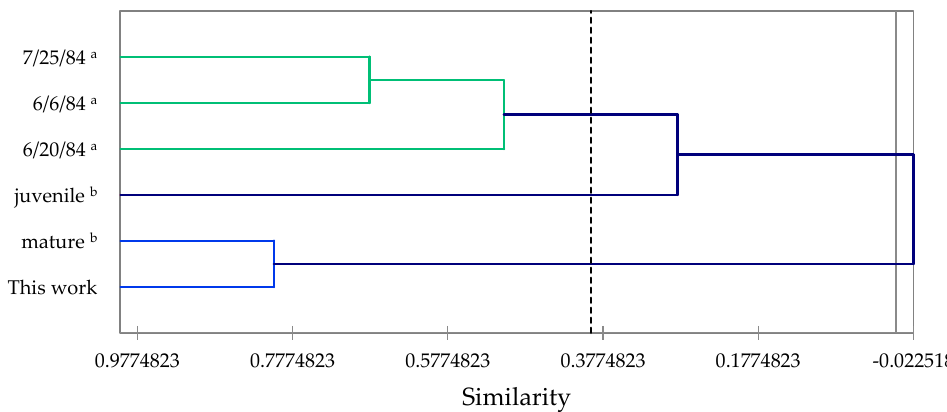
Figure 11. Dendrogram based on hierarchical cluster analysis of Picea engelmannii foliar essential oil compositions. a Wagner et al., 1989 [31]. b Mardarowicz et al., 2004 [32]. 2.1.3. Pinus contorta subsp. latifolia Leaves (needles) of P. contorta subsp. latifolia from two mature trees ( P.c.l. #1 and P.c.l. #2) were hydrodistilled to give colorless essential oils in 3.105% and 1.702% yield based